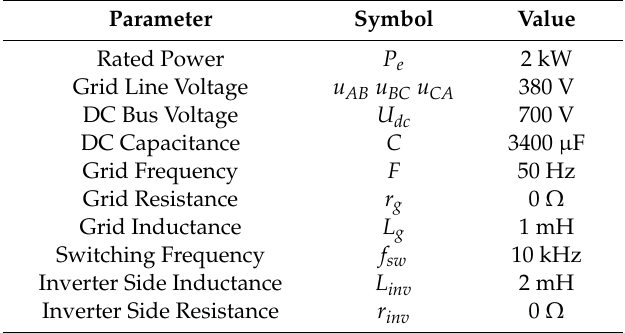
Table 2. The parameters of the LCL-type three-phase grid-connected inverter.